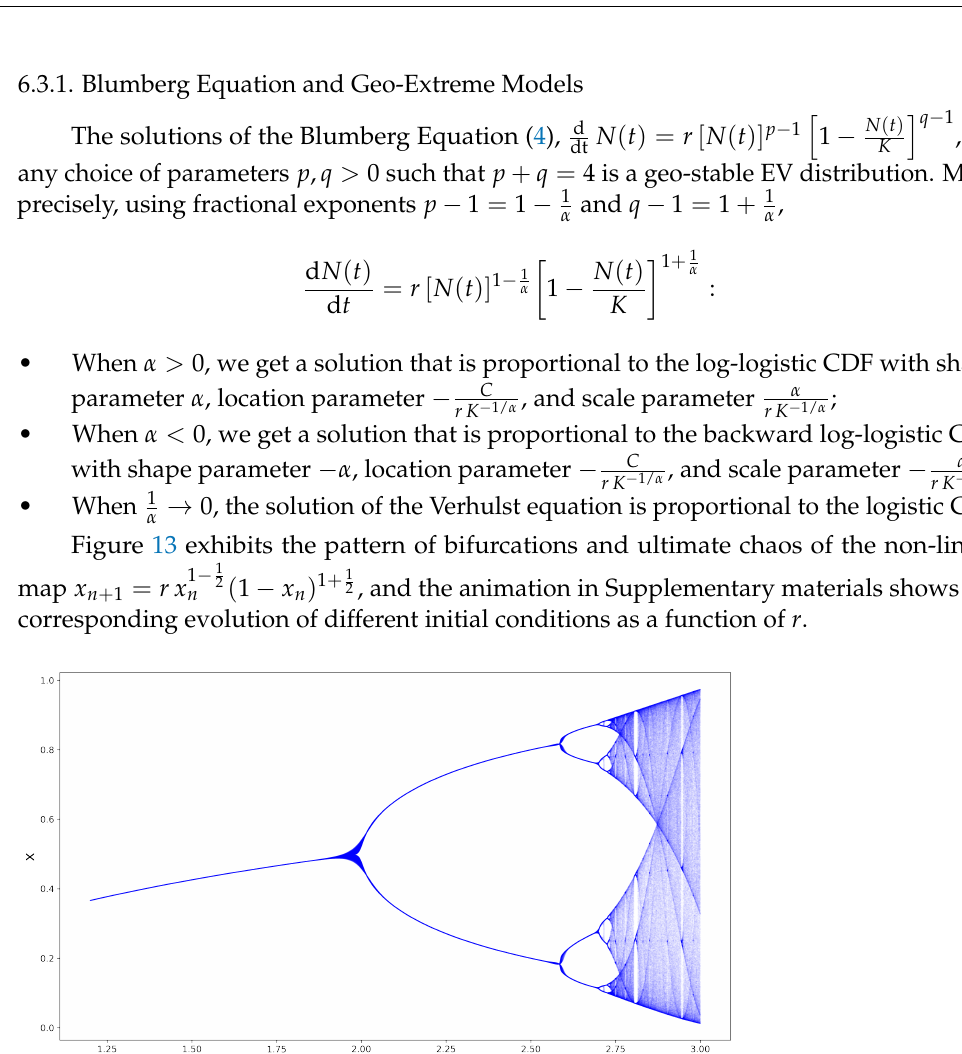
Figure 13. Bifurcation diagram for the Blumberg map x n + 1 = r x 1 Figure S1 in Supplementary